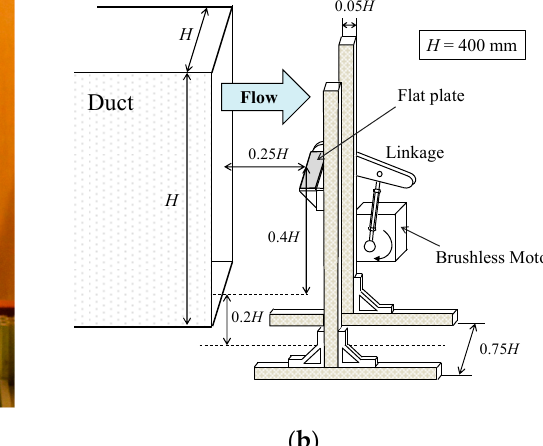
Figure 5. The experimental setup with link mechanism for oscillation of the plate. ( a ) Photograph; ( b ) Schematic sketch.